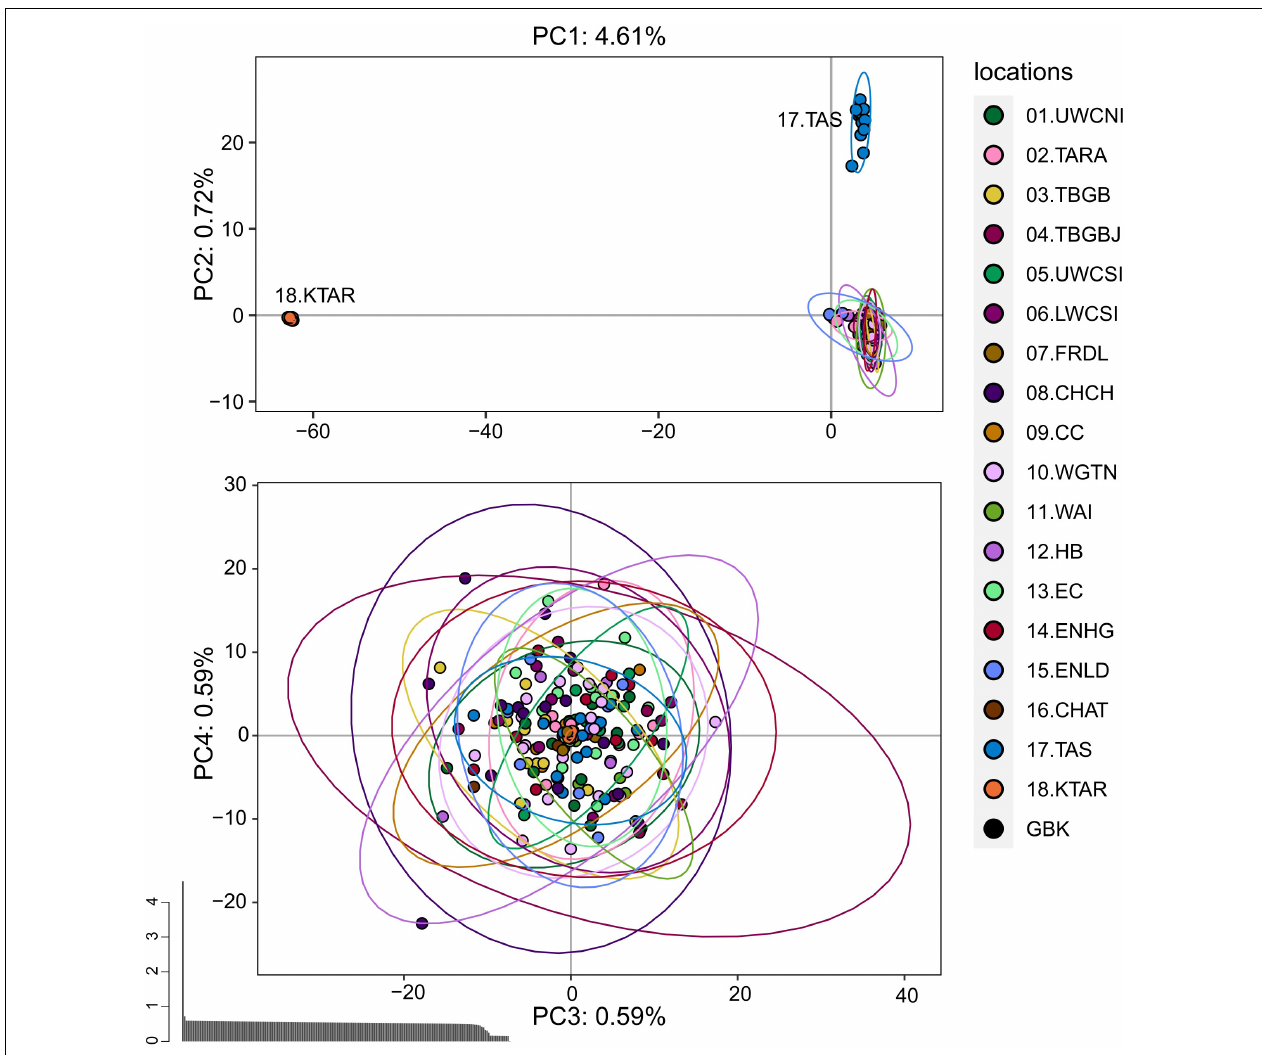
FIGURE 5 | Principal component analysis of the pruned SNP dataset that includes 183,443 loci from 188 tarakihi and king tarakihi. Ellipses represent the 95% confidence intervals. Top: Axes 1 and 2. Bottom: Axes 3 and 4. Bottom left: Eigenvalues. Sampling location codes as referred to in Table 1